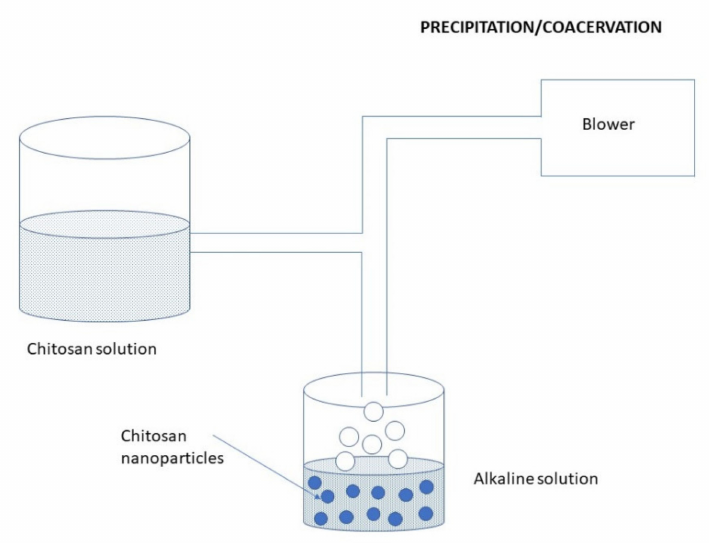
Figure 12. Preparation of CS NPs by the precipitation/coacervation